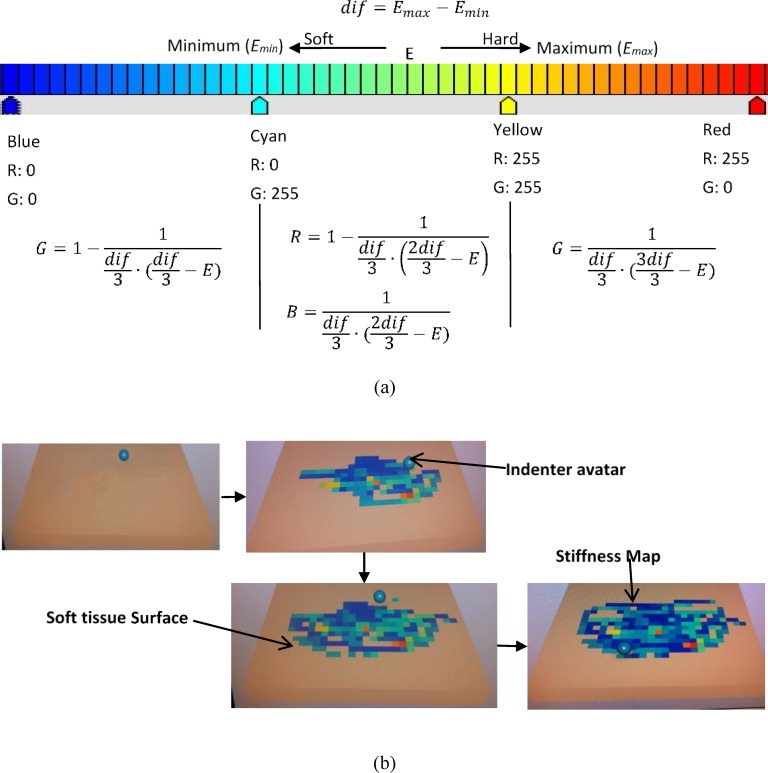
(a) Mapping stiffness data to RGB value and (b) stiffness map generation.